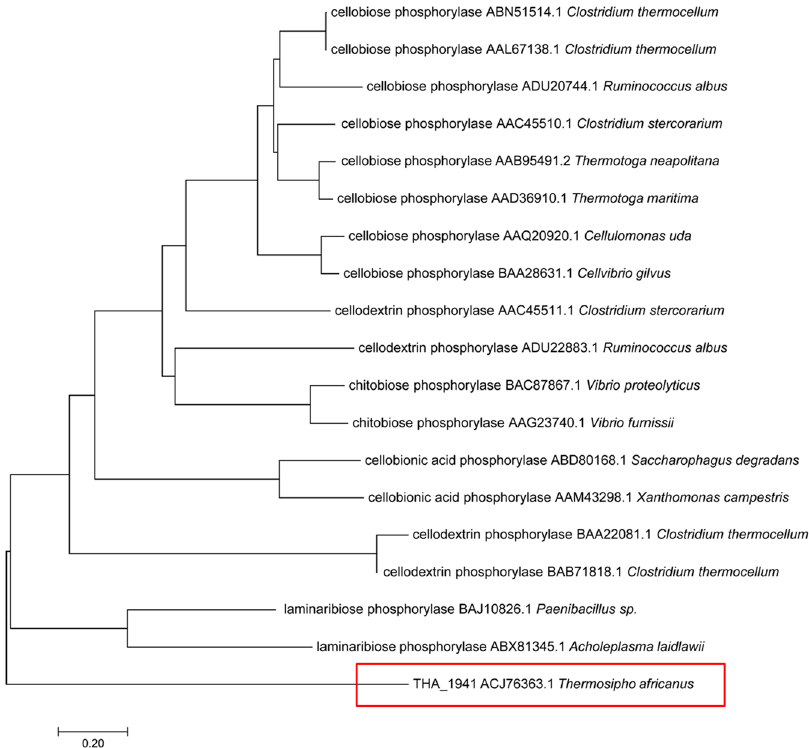
Figure 1. Phylogenetic relationship of THA_1941 with function-known GH94 enzymes. Phylogenetic tree was generated by Neighbour-Joining Method in MEGA